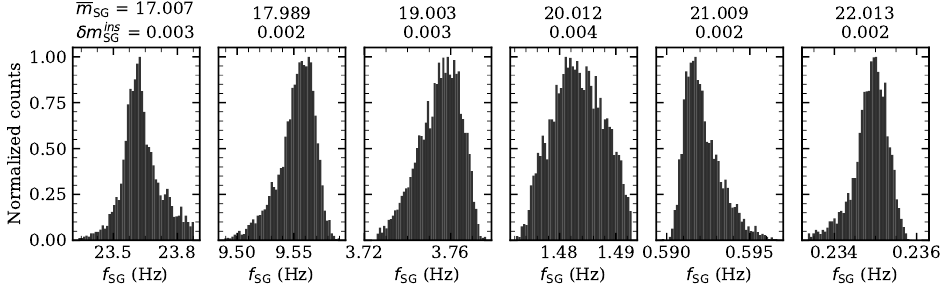
Figure 8. Distribution of 5000 laboratory frequency measurements with light intensities for m SG values included between 17 and 22 mag/arcsec 2 range in steps of 1 mag/arcsec 2 . The standard deviation in magnitude units, corresponding to the instrumental uncertainty, is included on